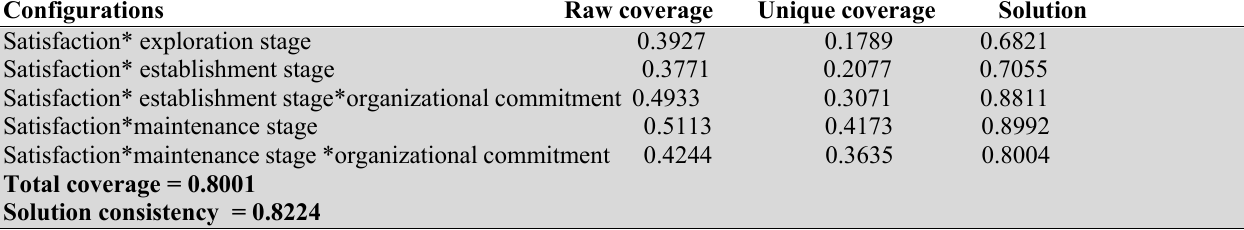
Configurations leading to the presence of a high level of contextual performance